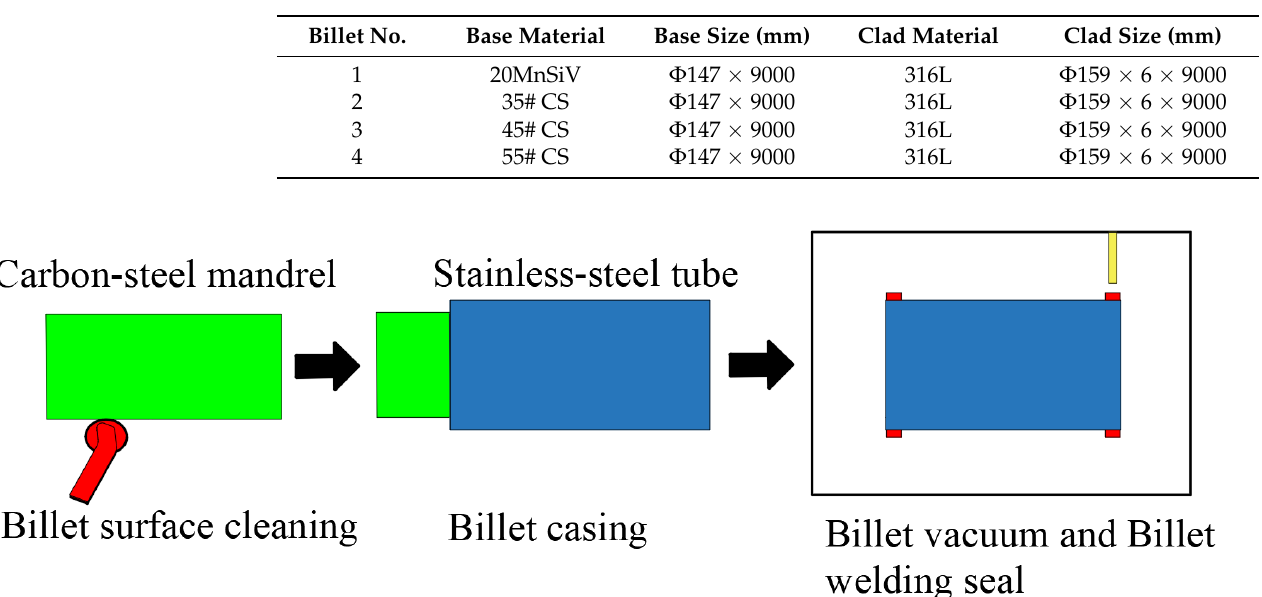
Figure 1. Assembly forming process flow.